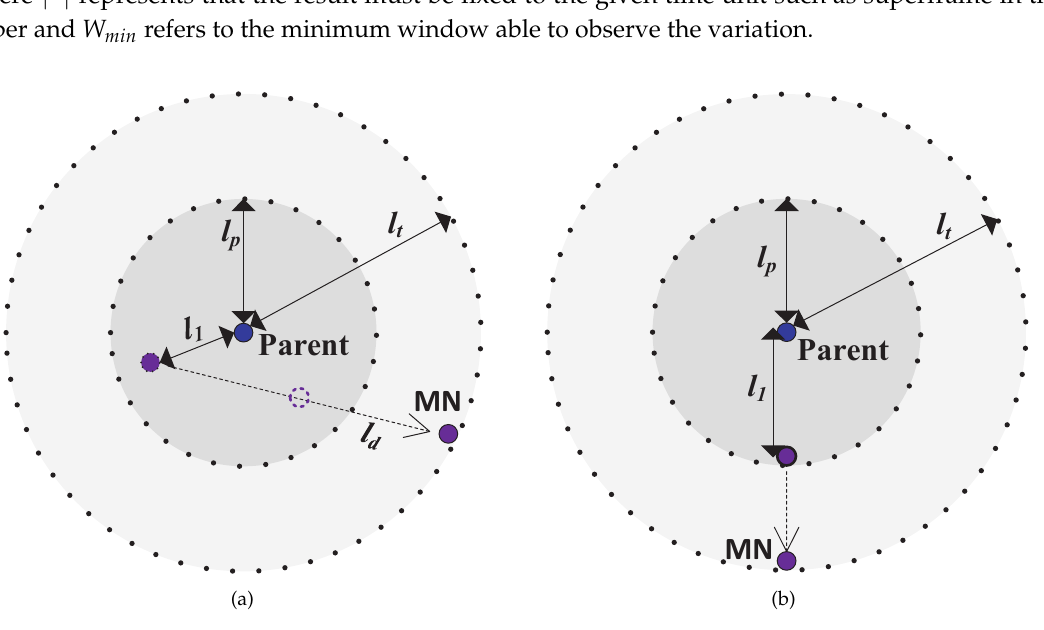
Figure 3. Normal case and worst case where MN is moving away from its parent. ( a ) The normal case; ( b ) The worst